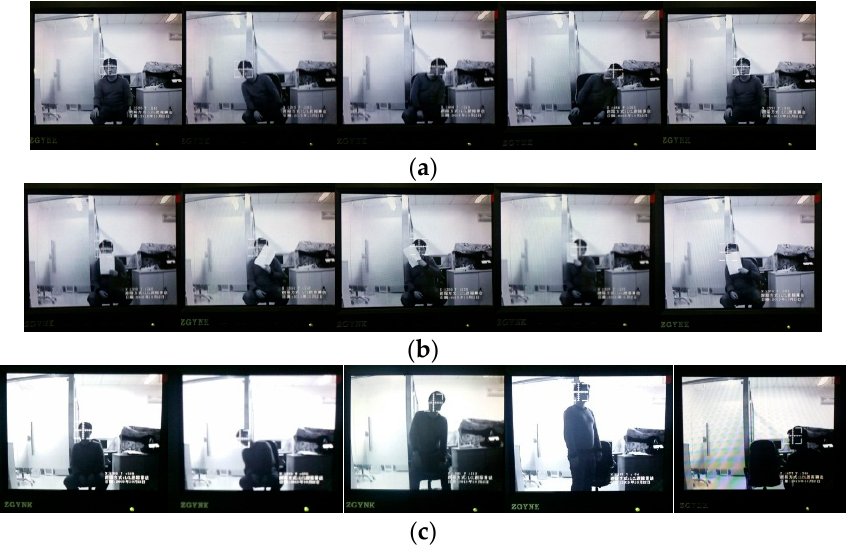
Figure 12. Experimental results of the real-time tracking system: ( a ) pose variation; ( b ) partial occlusion; and ( c ) illumination variation.